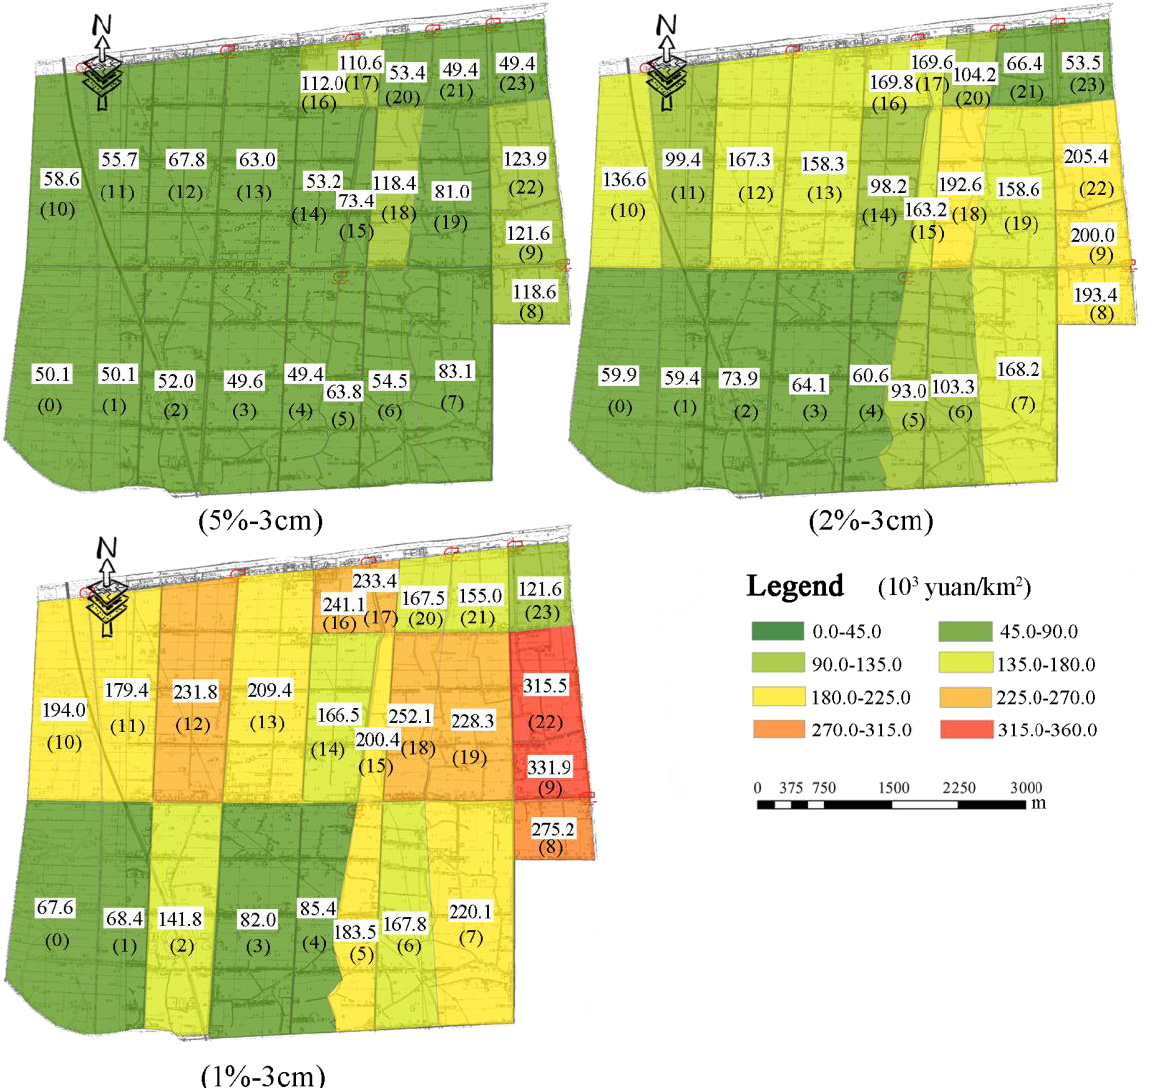
Figure 7. Distribution of waterlogging loss under different rainfall return periods of extreme scenario. Table 2. Waterlogging loss under extreme and current rainfall conditions (unit: 10 3 yuan).